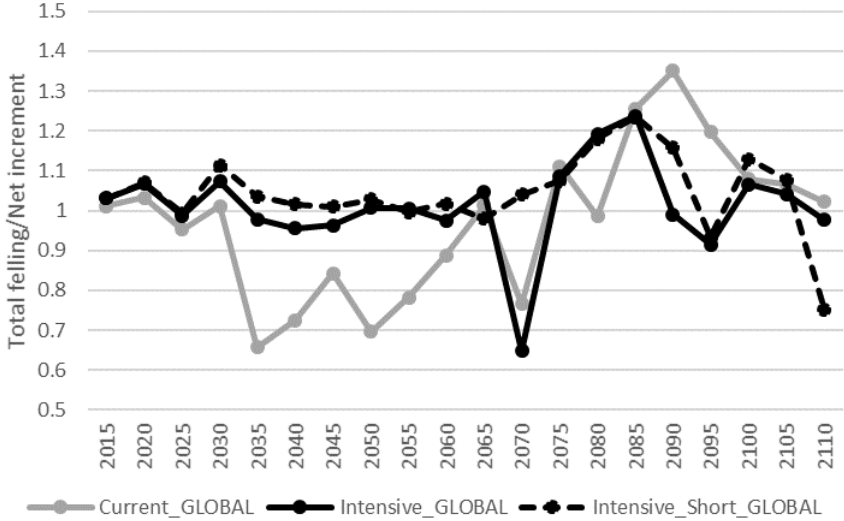
Figure 11. Projected utilization rates (total felling in PCTs, thinnings and final fellings / net increment) on the net forest area used for production (84.9% of the productive forestland, set-asides and retention areas in production stands are not included) with current forest management approaches of different intensities in the GLOBAL BIOENERGY scenario.